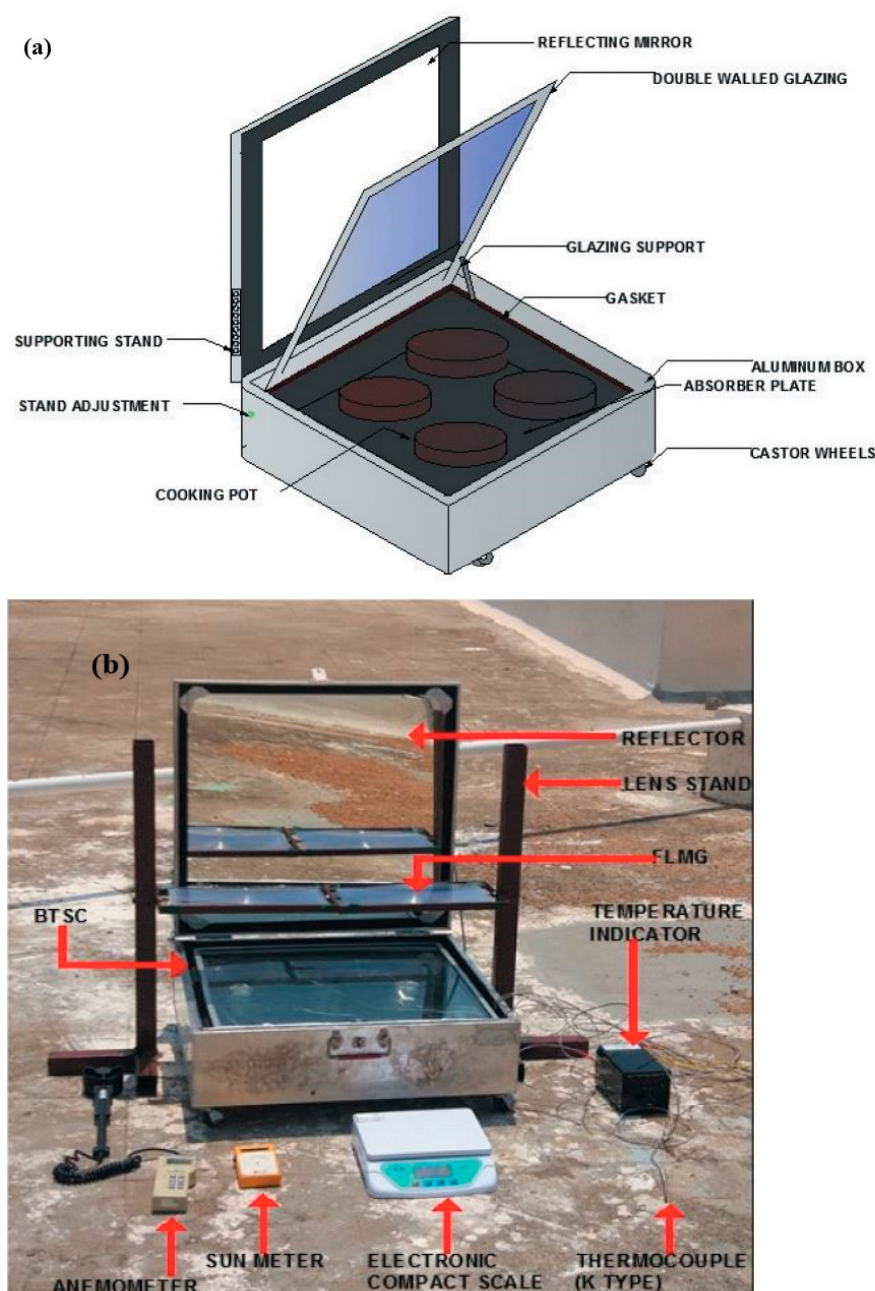
Figure 13. ( a ) Components of box-type solar cooker; ( b ) Experimental setup Mirror. Reprinted/adapted with permission from Ref. [41], 2020, Taylor & Francis online.